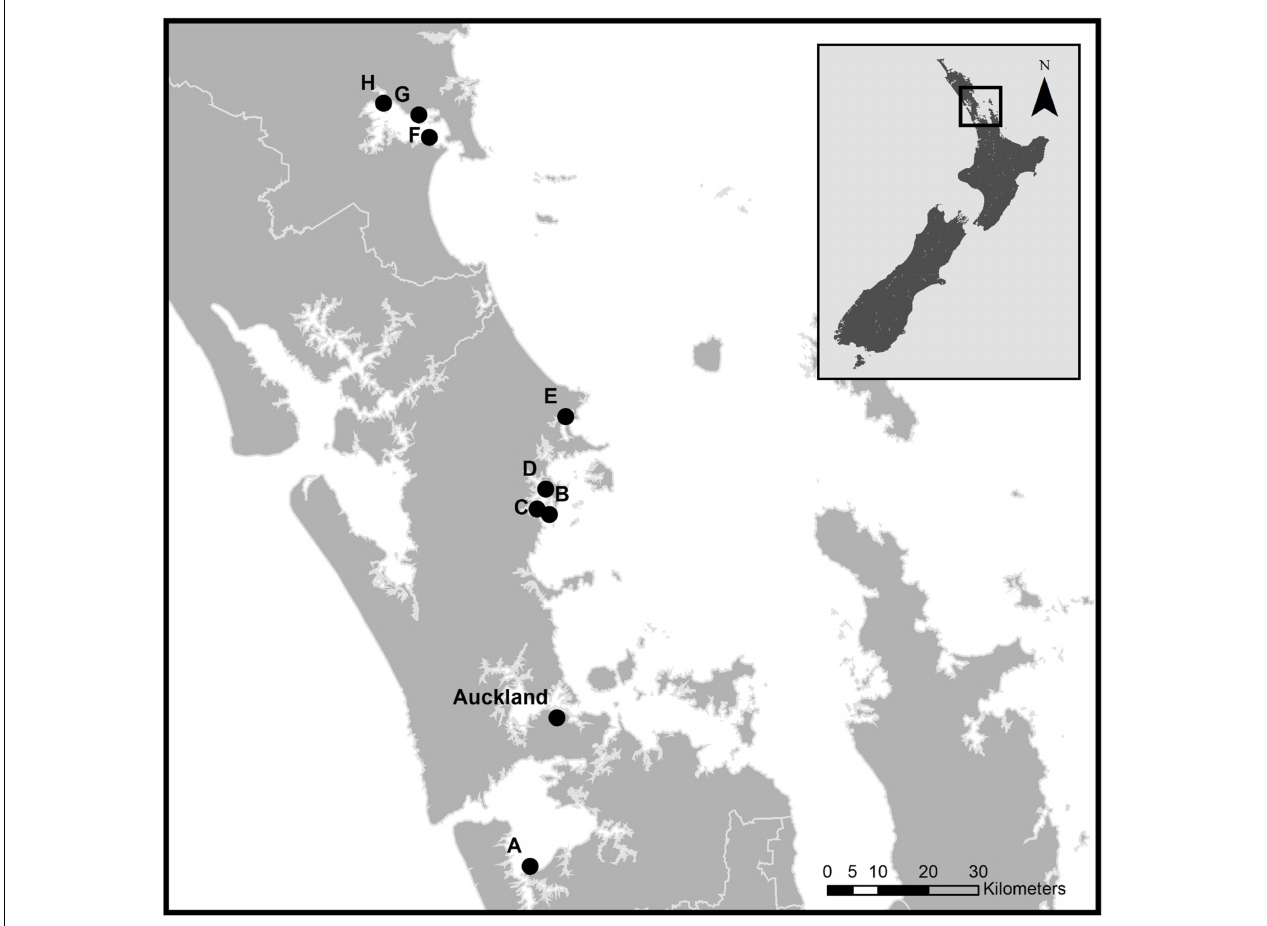
FIGURE 1 | Location of the eight field sites across the North Island of New Zealand (inset) and their proximity to Auckland City. (A) Manakau Harbor (MK); (B) , (C) and (D) Mahurangi Harbor sites 1-3 respectively (MH1, MH2, MH3); (E) Whangateau Harbor (WG); (F) , (G) and (H) Whangarei Harbor sites 1-3 respectively (WR1, WR2, WR3). GPS co-ordinates are provided in Supplementary Table 1